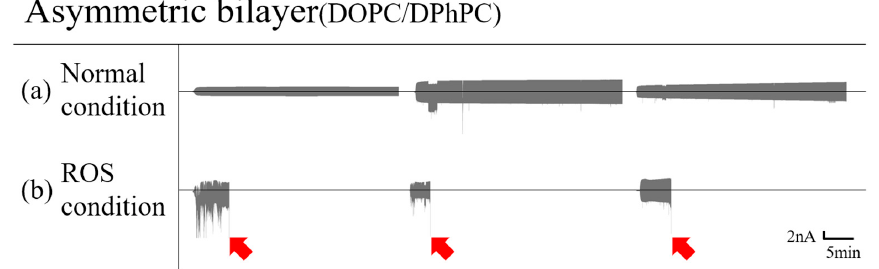
Figure 2. Asymmetric planar lipid bilayer electric current graph with a triangle wave voltage; the middle line of each graph is zero amperes. Red arrows indicate that the droplets no longer remain intact. Asymmetric bilayer in the absence of ROS ( a ) and in the presence of ROS ( b ).